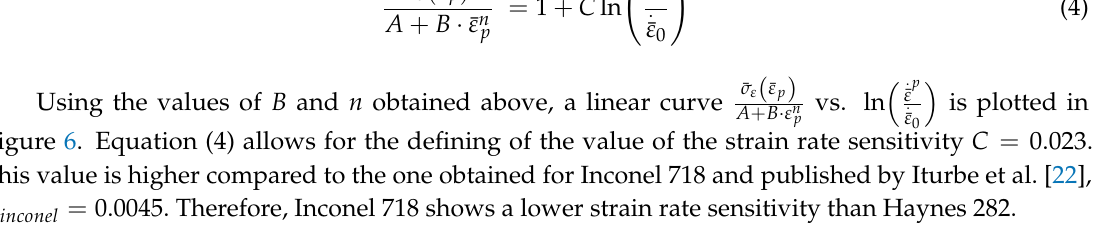
Table 3. Parameters obtained for strain hardening-softening and comparison with Inconel 718 [22]. Material